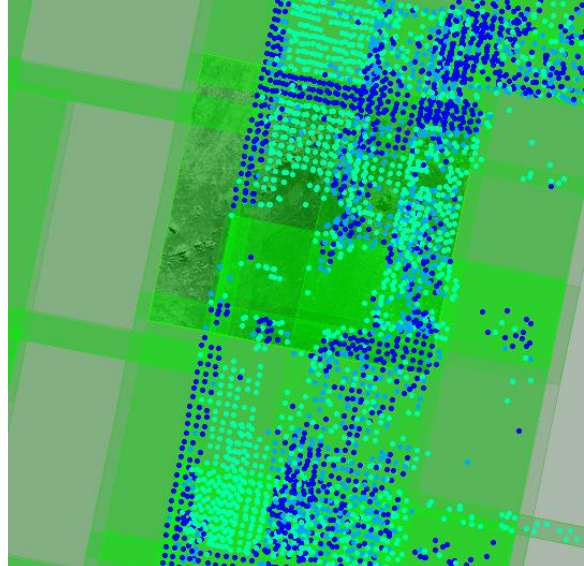
Figure 14. Unreasonable distribution of connection points